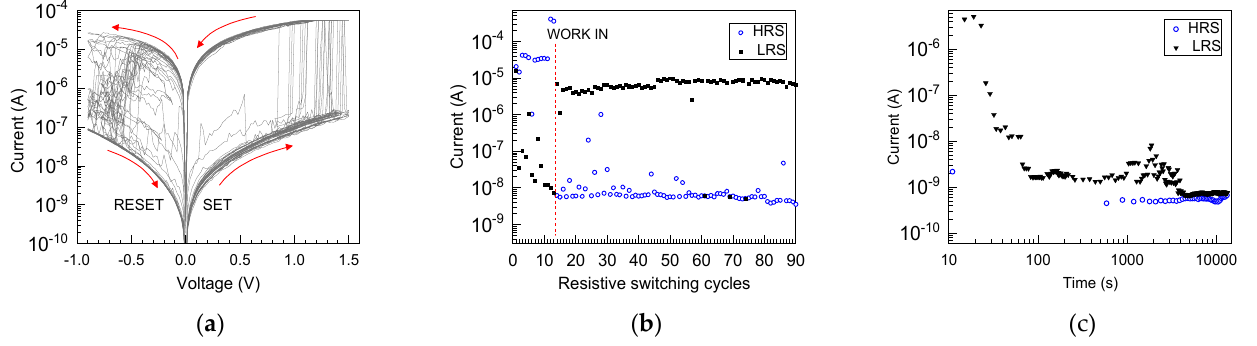
Figure 9. Current–voltage ( a ), endurance ( b ), and retention ( c ) characteristics measured in resistive switching regime on the TiN/SiO 2 /graphene/HfO 2 /Ti (Sample 3 in Table 1) cell structure built on the TiN/SiO 2 base stack annealed at 1000 °C. The low- and high-resistivity states, denoted by LRS and HRS, respectively, were recorded at voltages of 0.2 V.